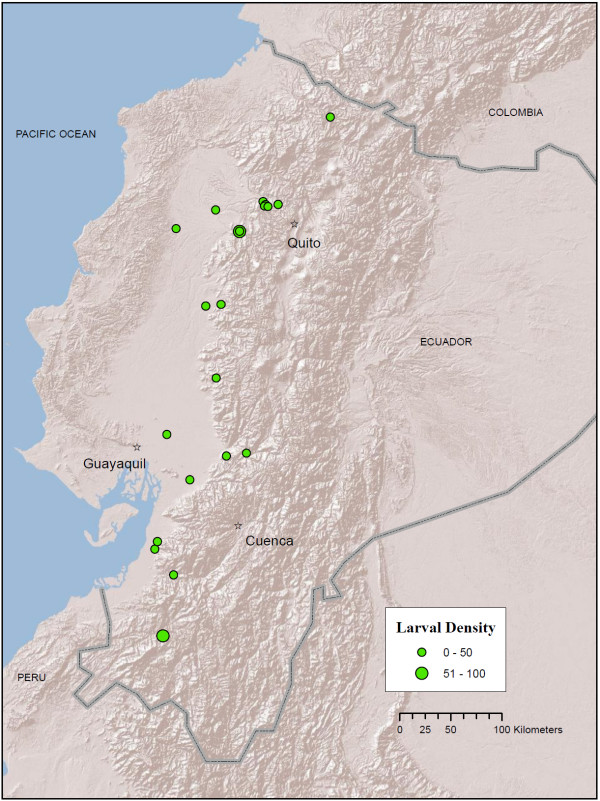
Map of An. punctimacula localities in Ecuador (green circles) from larval collections conducted between 2008 - 2010. Circle size (legend) indicates mean number of larvae per dip in a 30-dip sample. Map prepared in ArcGIS v.9.3 with ESRI World Terrain base [59].